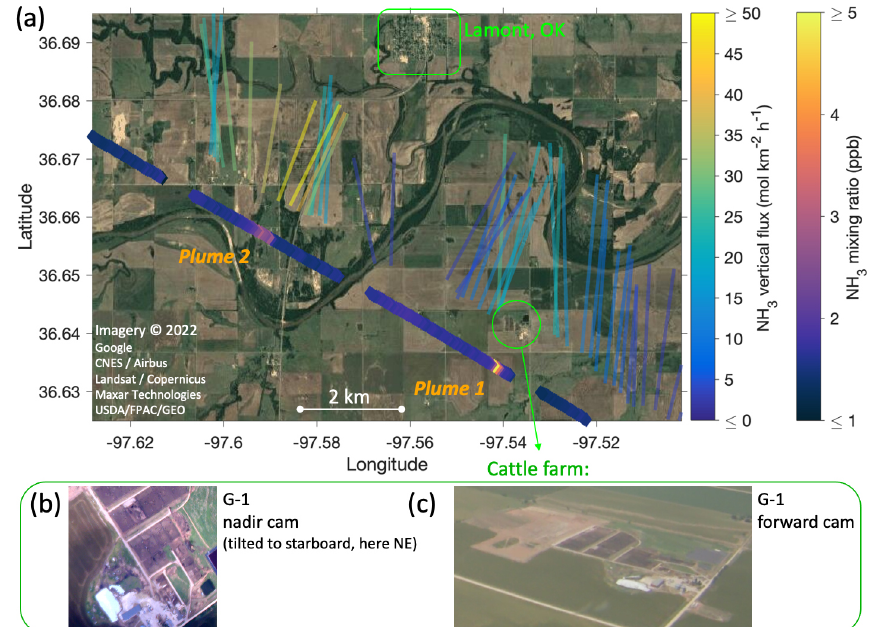
Figure 12. (a) Close-up view of Fig. 10 for the two NH 3 plume transects south of the town of Lamont, OK. As in Fig. 10, the IQR of the flux footprints are overlaid on satellite imagery and color-coded for the measured fluxes using the same color scale. Additionally, measured NH 3 mixing ratios are shown by separately color-coded markers along the flight track. Panels (b) and (c) are photographs of the cattle farm identified as the source of plume 1, made by the nadir and forward cameras on the G-1 aircraft, respectively. (The nadir camera was slightly tilted to starboard, allowing the farm to come into